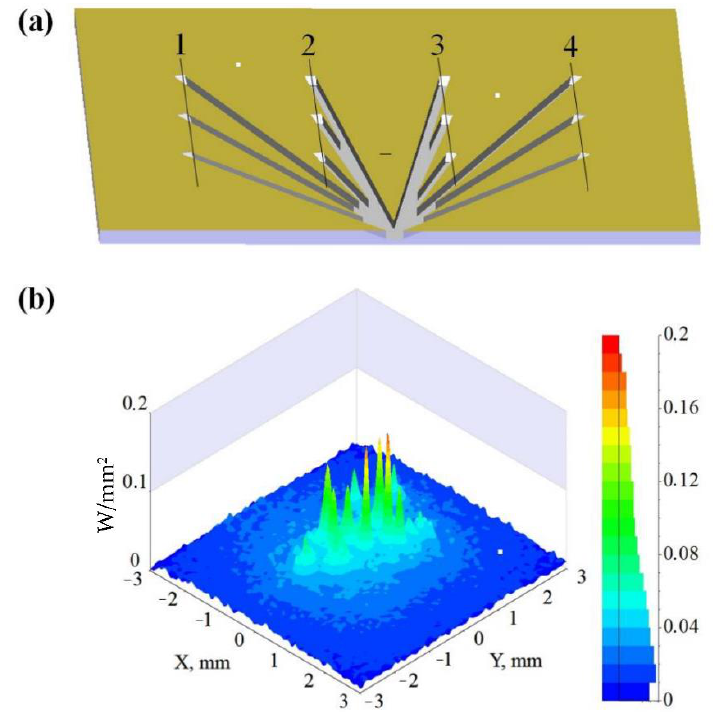
Figure 12. ( a ) Design of the secondary concentrator is comprised of 12 pairs of mirror + reflective channel, aiming to guide all beams to a sole area at the exit. ( b ) Light distribution at the exit of the secondary concentrator indicates an inhomogeneous illumination area as a consequence of divergence phenomena.